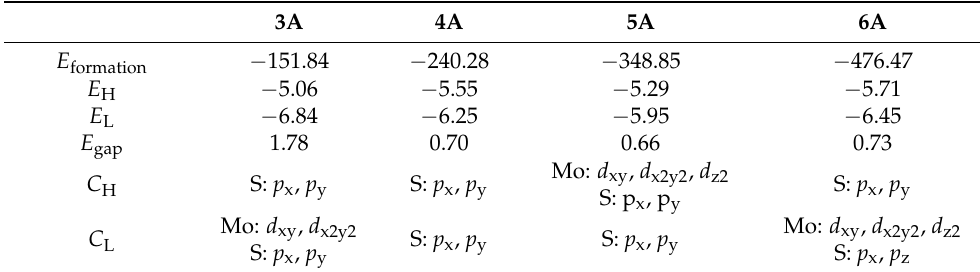
Table 1. Formation energy E formation (eV), energy of the highest occupied molecular orbital (HOMO) E H (eV), energy of the lowest unoccupied molecular orbital (LUMO) E L (eV), energy gap between HOMO and LUMO E gap (eV), as well as orbital composition of HOMO C H and LUMO C L of 3A , 4A , 5A , and 6A